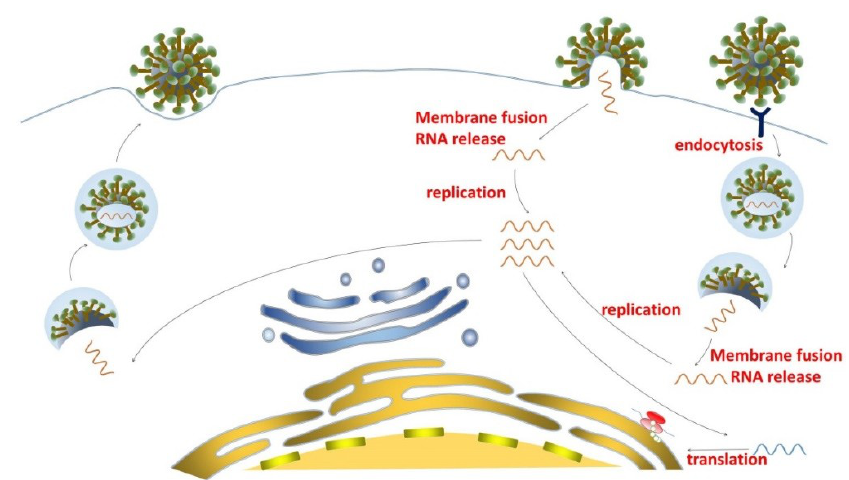
Figure 2. Schematic diagram of Middle East respiratory syndrome coronavirus (MERS-CoV) infection. MERS-CoV enters host cells by plasma membrane fusion (membrane fusion) or endosomal membrane fusion (endocytosis), and then releases the viral RNA into the cytoplasm. The RNA genome is replicated and viral proteins are produced. The progeny virus is generated and released from the infected cells.